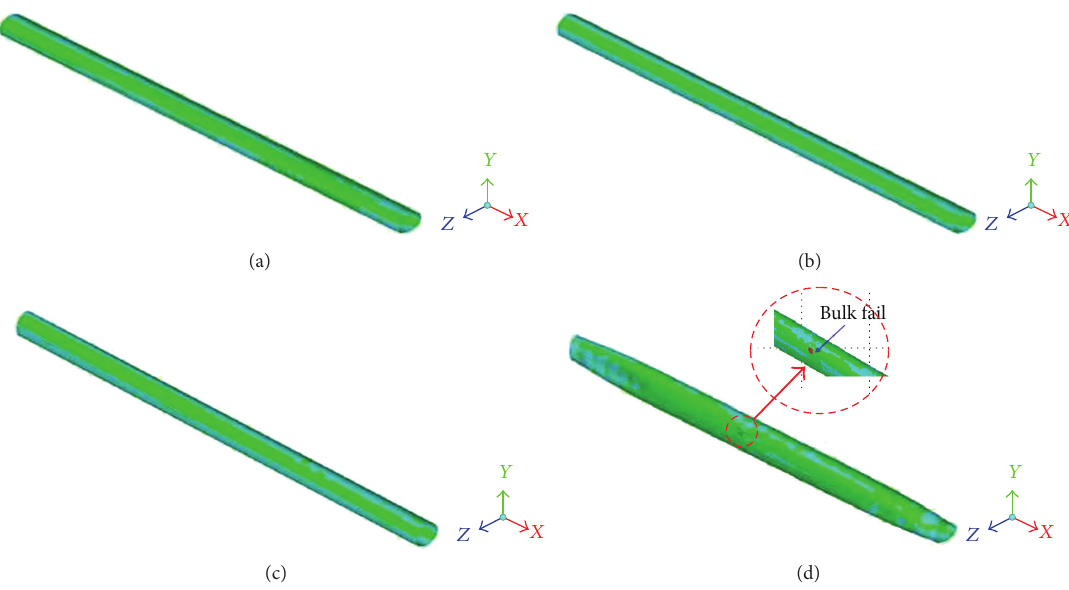
Figure 13: Material status of one-sided detonation expanding tube ((a): 15gr/ft, (b): 20gr/ft, (c): 25 gr/ft, and (d): 30 gr/ft).